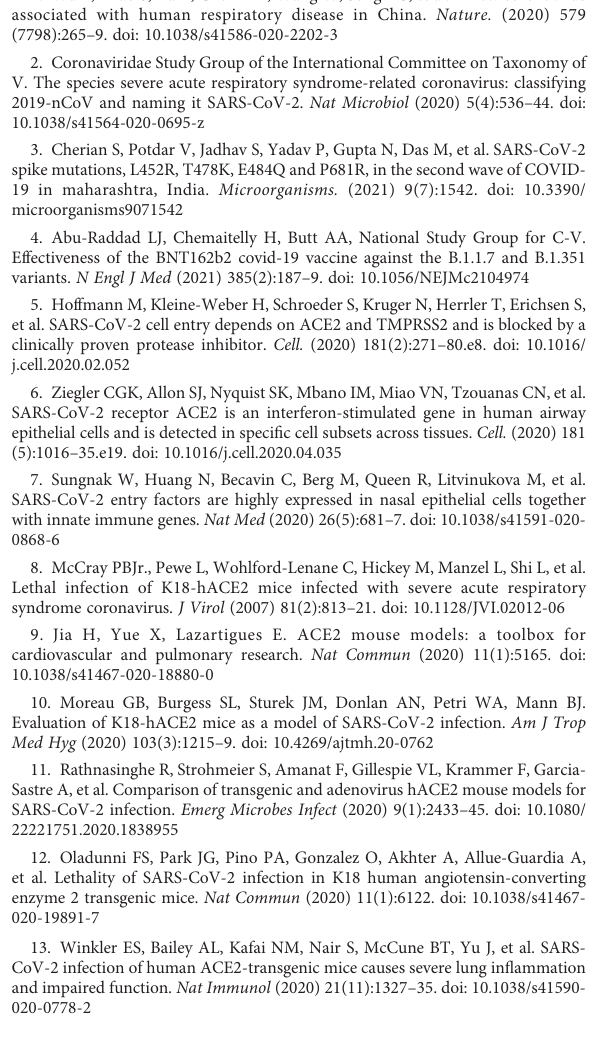
SUPPLEMENTARY FIGURE 7 Histopathological analysis of the spleen in SARS-CoV-2-infected K18- hACE2, SFTPB-hACE2, and SCGB1A1-hACE2 mice. (A – C) Pathological analysis of the spleen following intranasal infection of 1 ×10 5 PFU SARS- CoV-2 in K18-hACE2 (A) , SFTPB-hACE2 (B) , and SCGB1A1-hACE2 (C) mice. Autopsy was conducted at 1, 2, 5, and 7 dpi. The scale bars are 100 m m (left panels) and 50 m m (right panels). SUPPLEMENTARY FIGURE 8 Immune cell distribution in the SARS-CoV-2-infected spleen of K18-hACE2 mice. The B cell marker PTPRC, T cell marker CD3, and macrophage marker F4/80 were stained in SARS-CoV-2-infected K18-hACE2 mice. SUPPLEMENTARY FIGURE 9 Lesion and infectious target cells in the brain of SARS-CoV-2-infected SFTPB-hACE2 and SCGB1A1-hACE2 mice. Brain lesion, diagnosed as perivesicular cof fi ng, was not detected in the brains of SFTPB-hACE2, SCGB1A1-hACE2, and control mice at 5 dpi (A) . SARS-CoV-2 infectious target cells in the brain of K18-hACE2 mice (B) . SARS-CoV-2 viral particles were detected in K18-hACE2 mice (red arrow) (C)